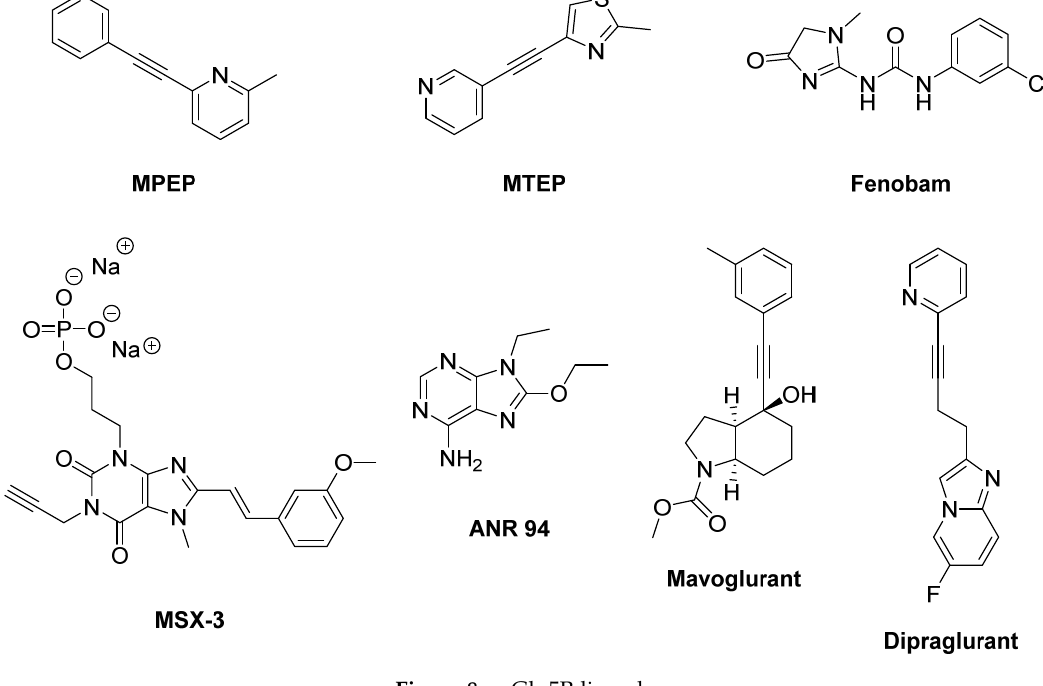
Figure 8. mGlu5R ligands.